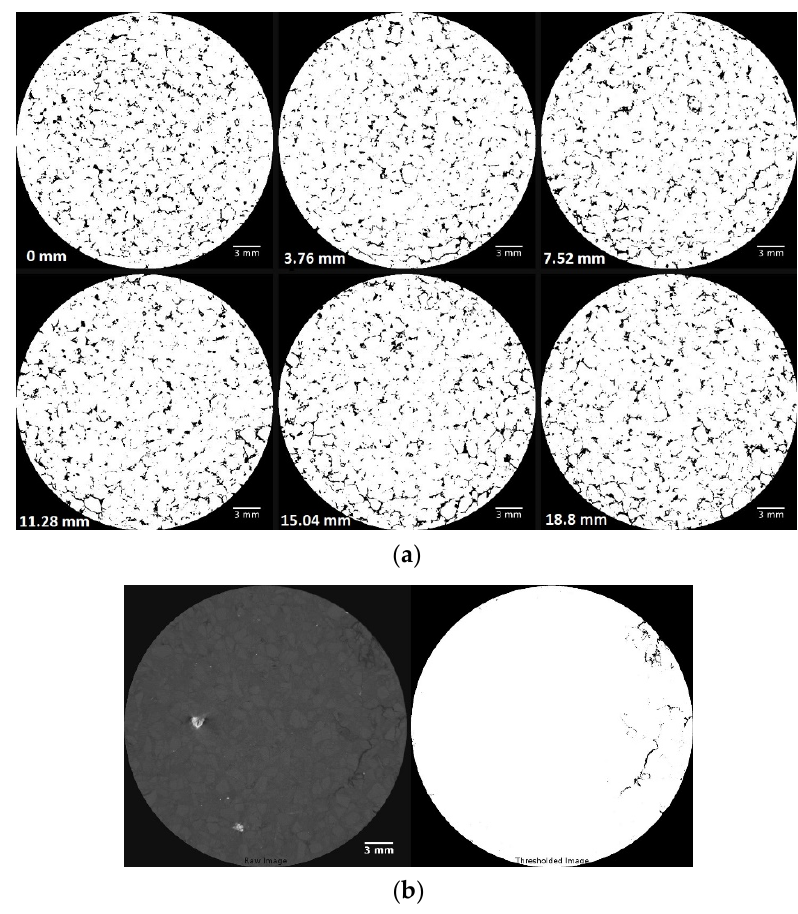
Figure 19. Image analysis using ImageJ software for dry granular samples after one-dimensional compression: ( a ) HN grain sample; ( b ) GLAG grain sample.